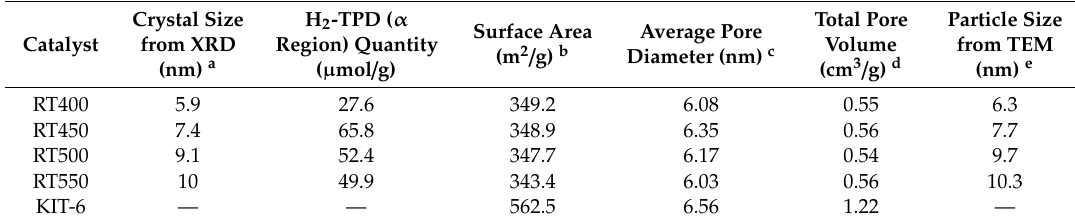
Table 1. Physicochemical properties of RTx